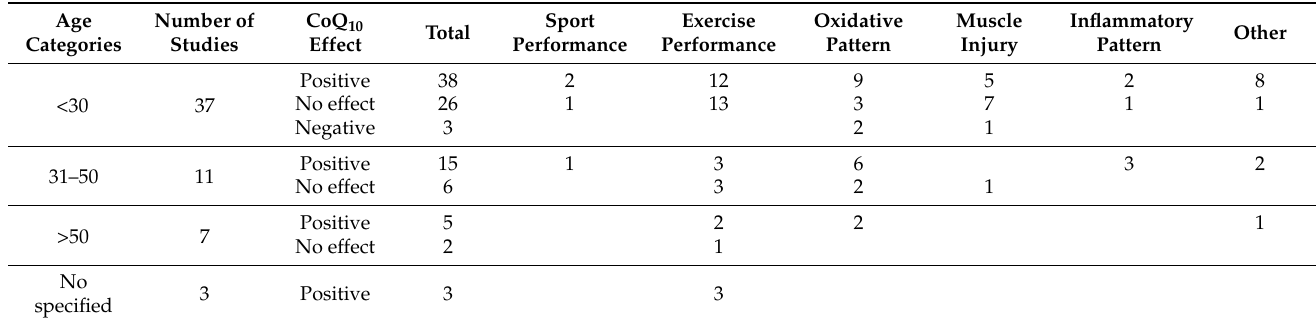
Table 11. Results of the Ubiquinone and Ubiquinol supplementation on different sport and exercise variables depending on the age categories of the subjects